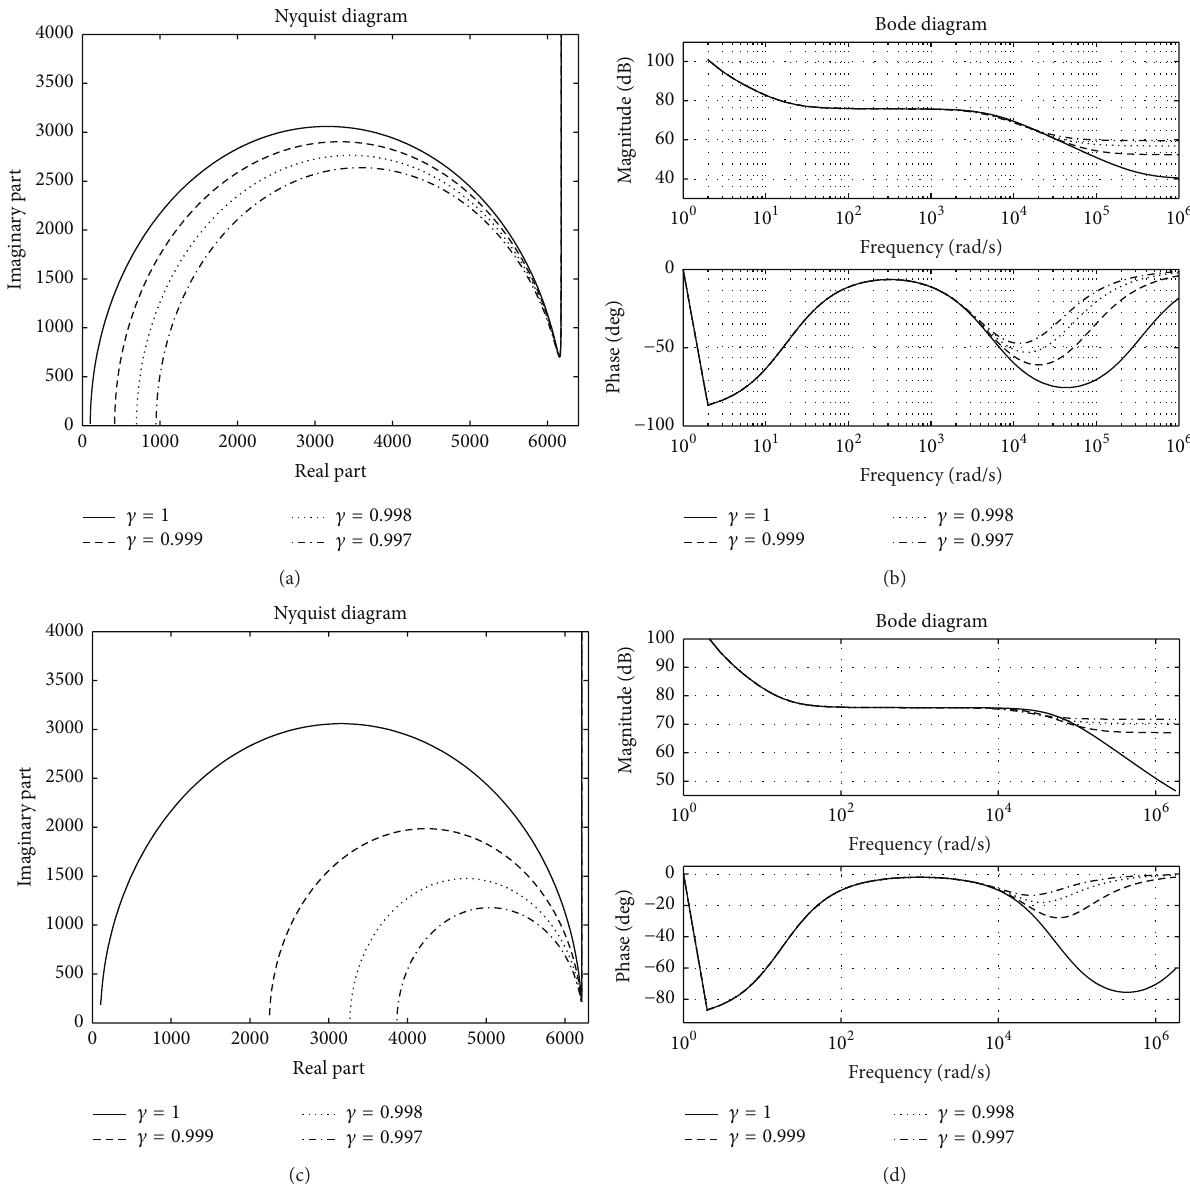
Figure 10: Nyquist and Bode diagram for the limited diffusion model, Caputo-Fabrizio derivative approach, in (a) and (b): 𝑅 𝑠 = 100 Ω , = 5000 Ω , 𝐶 = 3 −6 F, and 𝐶 = 1 −3 F for 𝛽 = 1/2 corresponding to 𝐶 𝑅 𝑝 𝑠 𝑝 = 3 −7 F, and 𝐶 = 1 −3 F for 𝛽 = 0.4 corresponding to 𝐶 𝐶 𝑠 𝑝